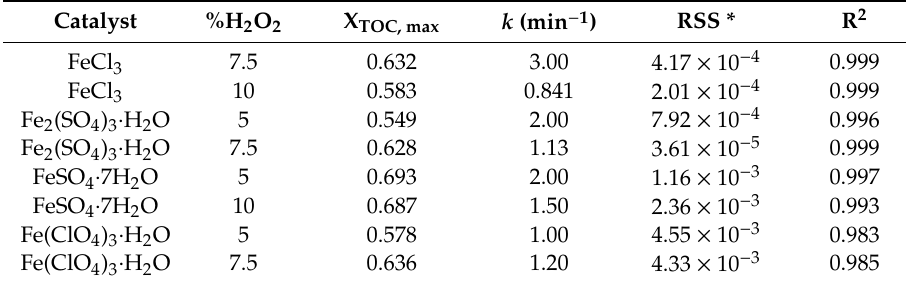
Table 5. Kinetic parameters determined for the best operational conditions of each catalyst